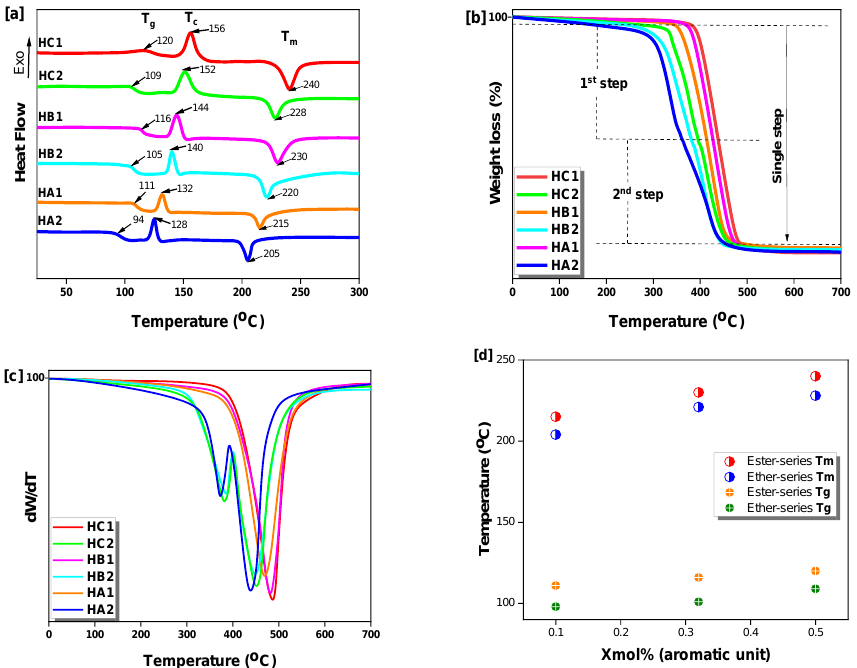
Figure 8. ( a ) DSC, ( b ) TGA, ( c ) DTG of poly(ether-ester)s and ( d ) relation between T g , T m and composition. Table 2. Thermal properties of poly(ether-ester)s measured by TGA and DSC.